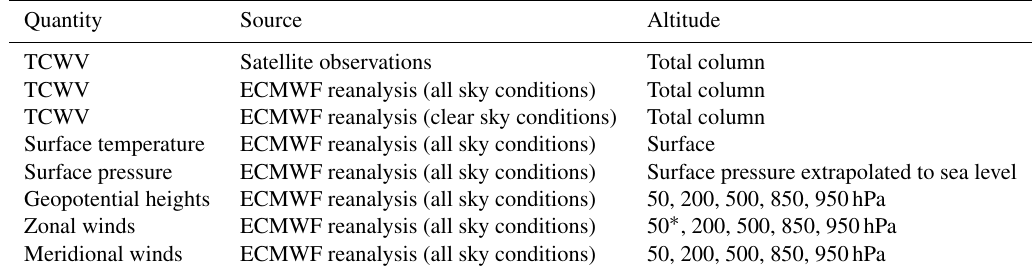
Table 1. Meteorological data sets used in this study.